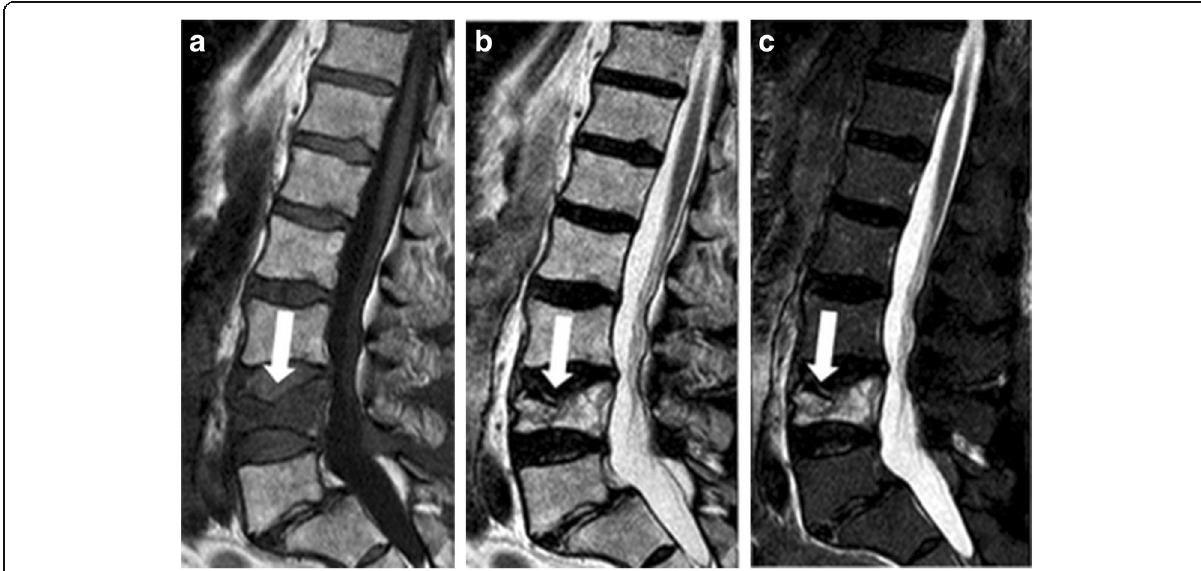
Fig. 1 A 72-year old male/female patient with lumbar vertebral fracture treated with image-guided elastoplasty. MRI before treatment: sagittal T1-weighted ( a ), proton density-weighted ( b ), and T2-weighted ( c ) images. A lumbar vertebral fracture in L4 is clearly visualised as decreased signal of the fractured vertebral body in ( a ) (arrow, a ) and increased signal in fractured vertebral body in ( b ) and ( c ) (arrow)